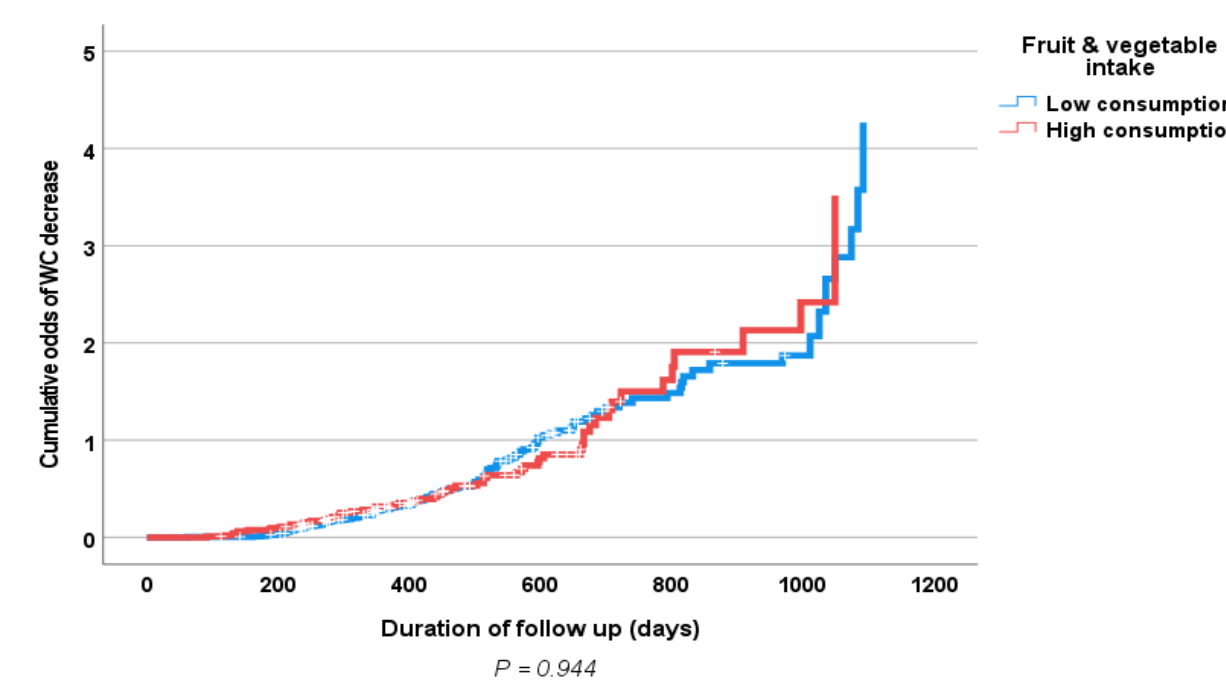
Figure 2. Kaplan–Meier curve of effects of follow-up fruit and vegetable consumption (high consumption >3.7 servings/day vs. low consumption ≤ 3.7 servings/day) on waist circumference (loss vs. gain).